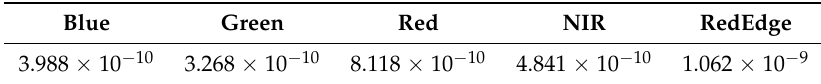
Table 10. RedEdge-3 radiometric calibration standard errors. Computed using the standard error for a regression estimate for all bands. Only 25 samples went into this computation, as the regression estimate itself contained only 25